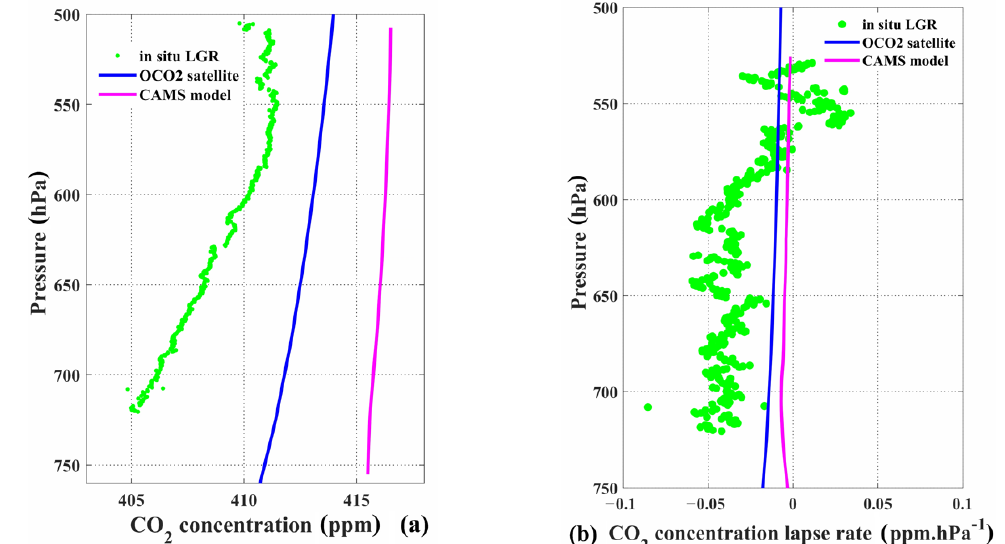
Figure 11. Comparison of vertical structures of CO 2 concentrations measured by airborne UGGA, OCO-2 satellite, and CAMS model ( a ) and the CO 2 concentration lapse rate of the airborne UGGA, OCO-2 satellite, and CAMS model ( b ). The green scatter is the measurement result of the airborne UGGA. The solid blue line is the measurement result of the OCO-2 satellite. The pink solid line is the calculation result of the CAMS model.